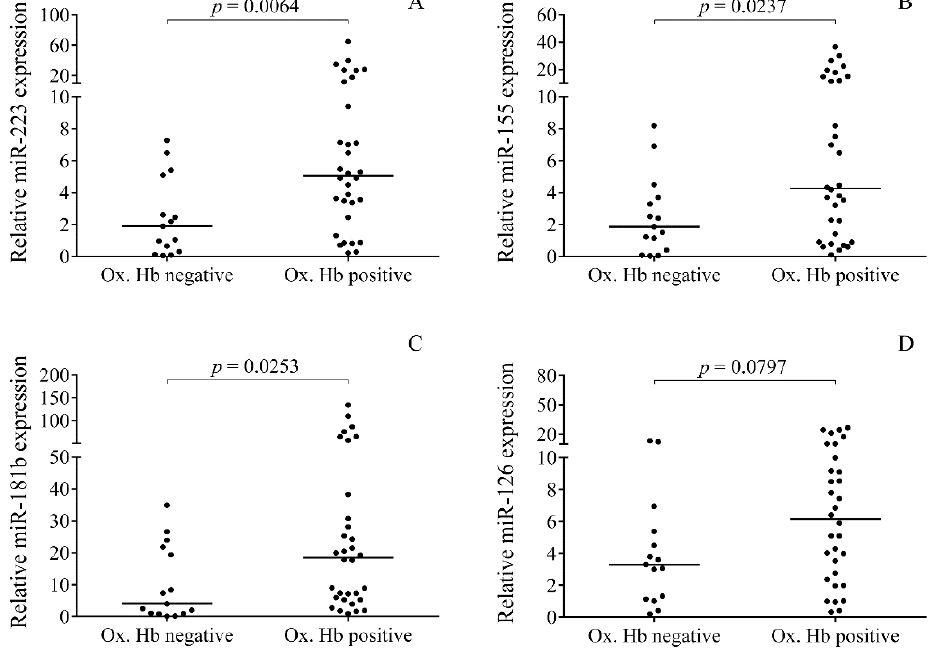
Figure 3. Oxidized forms of Hb were detected in 68% ( n = 32) of all baseline CSF samples. Thus, IVH samples were further subclassified based on the status of oxidized Hb content to investigate how the presence of oxidized Hb influenced cell-free miRNA levels. Significant upregulation was revealed for CSF miR-223 ( A ), miR-155 ( B ), and miR-181b ( C ) in oxidized Hb positive vs. negative subjects ( n = 15), while oxidized Hb content did not affect miR-126 levels ( D ). Dots represent single expression values. Median values are depicted. Mann–Whitney U test was performed for the comparison. CSF: Cerebrospinal fluid, IVH: Intraventricular hemorrhage, miRNA: MicroRNA, Ox. Hb: Oxidized hemoglobin.